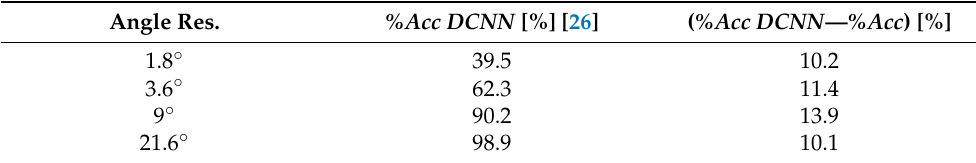
Table 5. Accuracy for DCNN and accuracy difference between two approaches. Angle